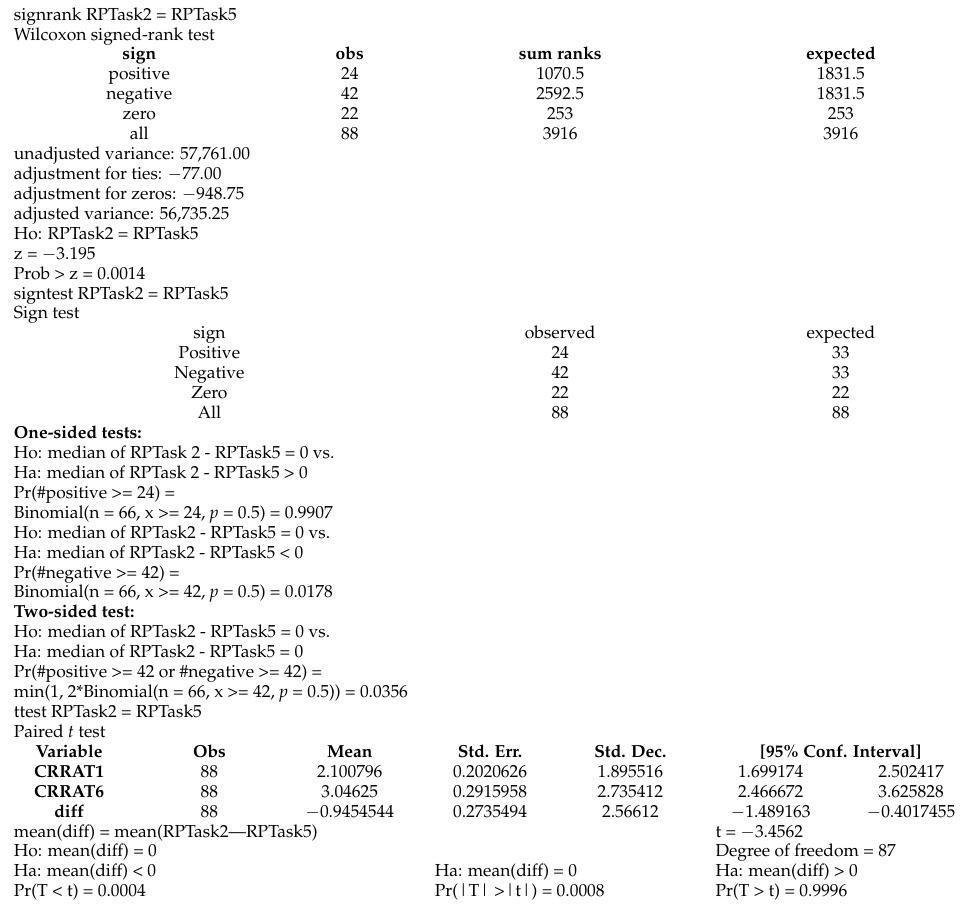
Table A8. Results of statistical tests based on the RP (including Wilcoxon matched-pairs signed-rank test, the Arbuthnott–Snedecor–Cochran sign test, and the two-sample T test for paired data).